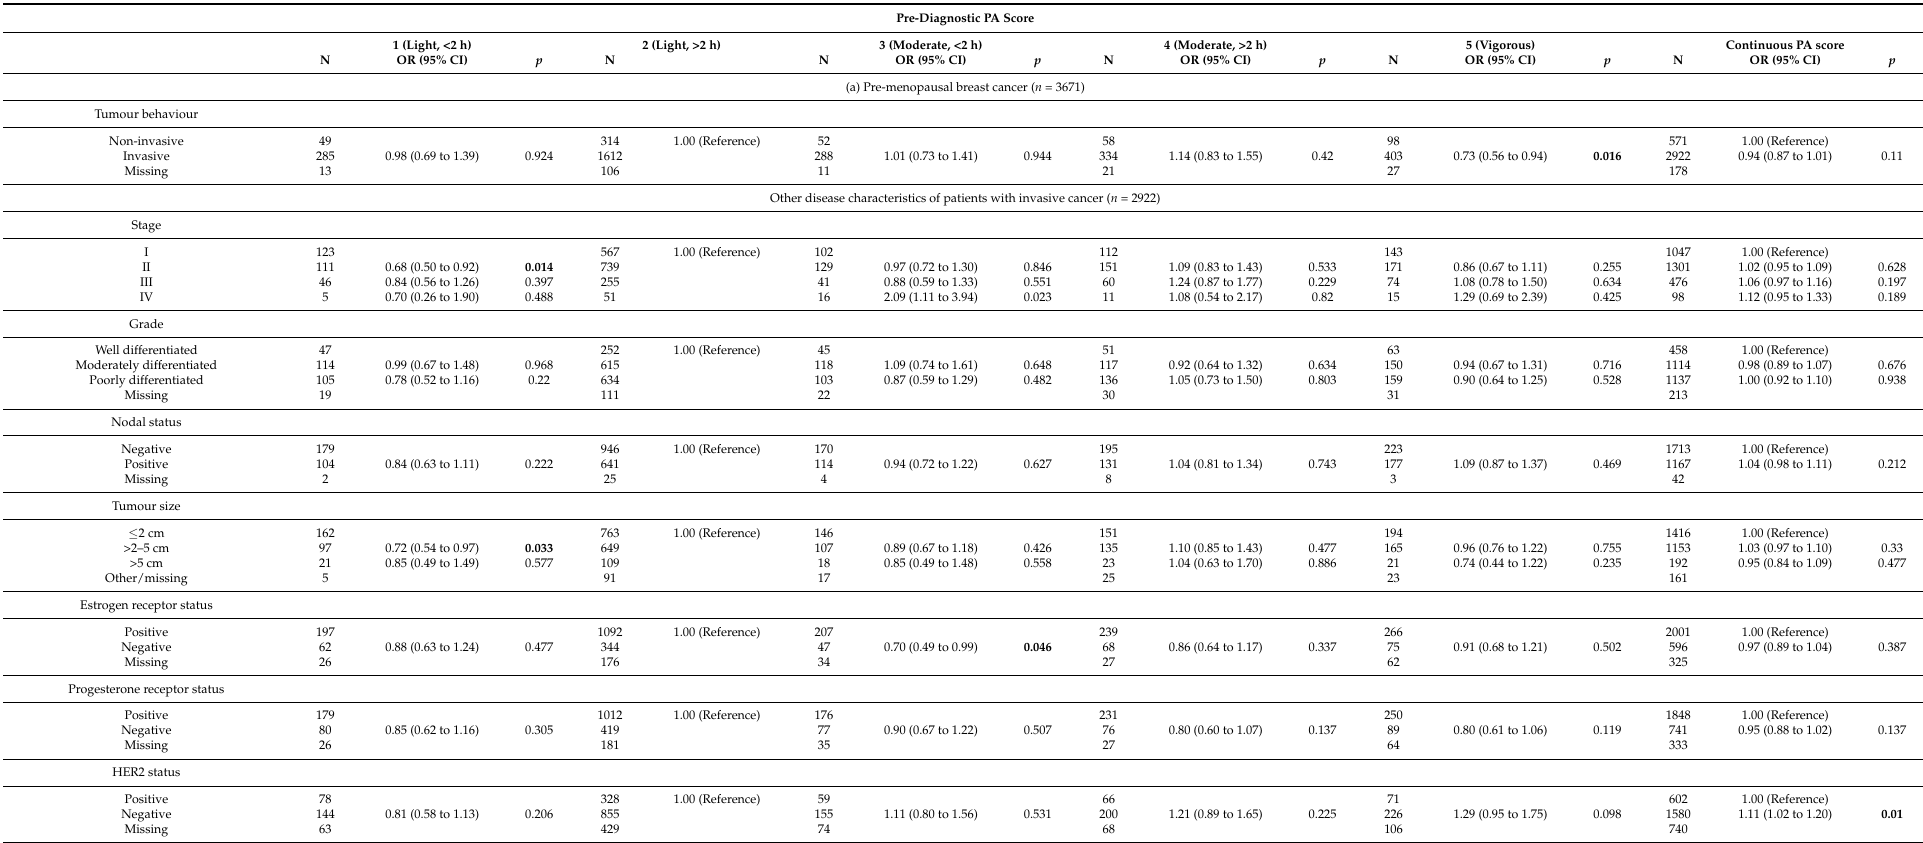
Table 4. Associations between pre-diagnostic physical activity (PA) score and disease characteristics adjusted for age at diagnosis, body size one year prior to diagnosis, ethnicity, and recruitment site for ( a ) pre-menopausal ( n = 3671) and ( b ) post-menopausal breast cancer ( n = 4017). Odds ratios (OR) and 95% confidence intervals (CI) were estimated using multinomial regression. P indicates p -value obtained from the Wald test. Results in bold indicate p ≤